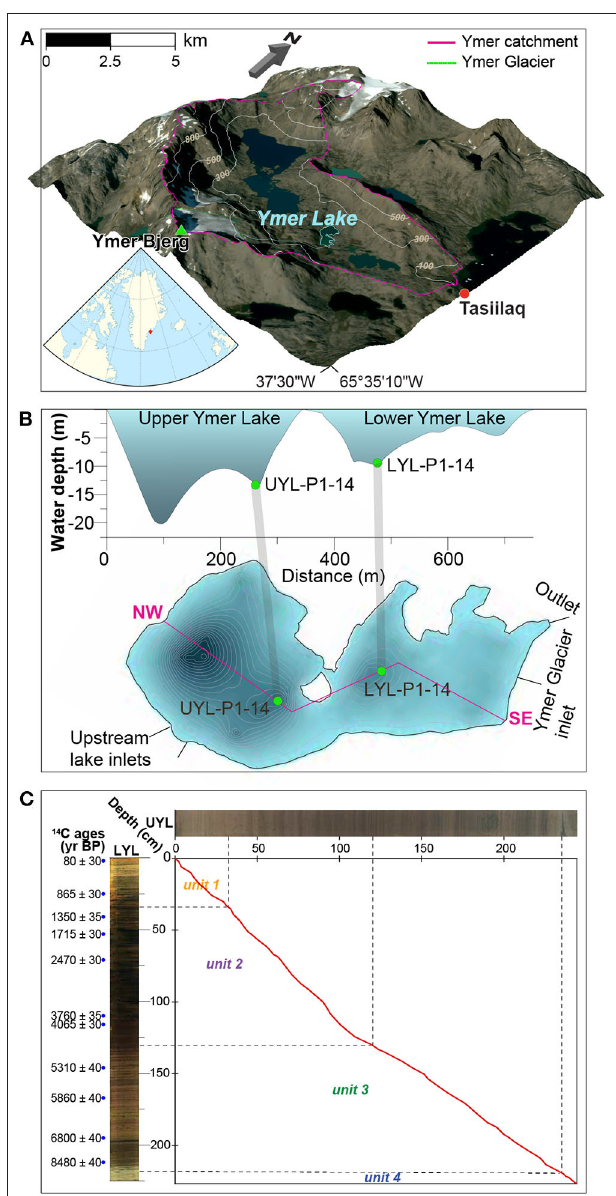
FIGURE 1 | (A) Overview of the catchment area showing Ymer Lake (cyan), Ymer Glacier and the larger, unnamed up-stream lake. Embedded: Regional map showing Greenland and nearby land. Embedded regional map by Tentotwo, Wikimedia Commons CC BY-SA 3.0. (B) Bathymetric map of Ymer Lake. One piston core was gathered from each basin of Ymer Lake. 1B is modified from van der Bilt et al. (2018) with permission. (C) Correlation of sedimentation rates based on 14 C-dating of LYL (Betula leaves, n = 13) was performed using AnalySeries 2.0.8. (Paillard et al., 1996) based on linear interpolation of n = 59 tie points. Blue dots mark dated depths in